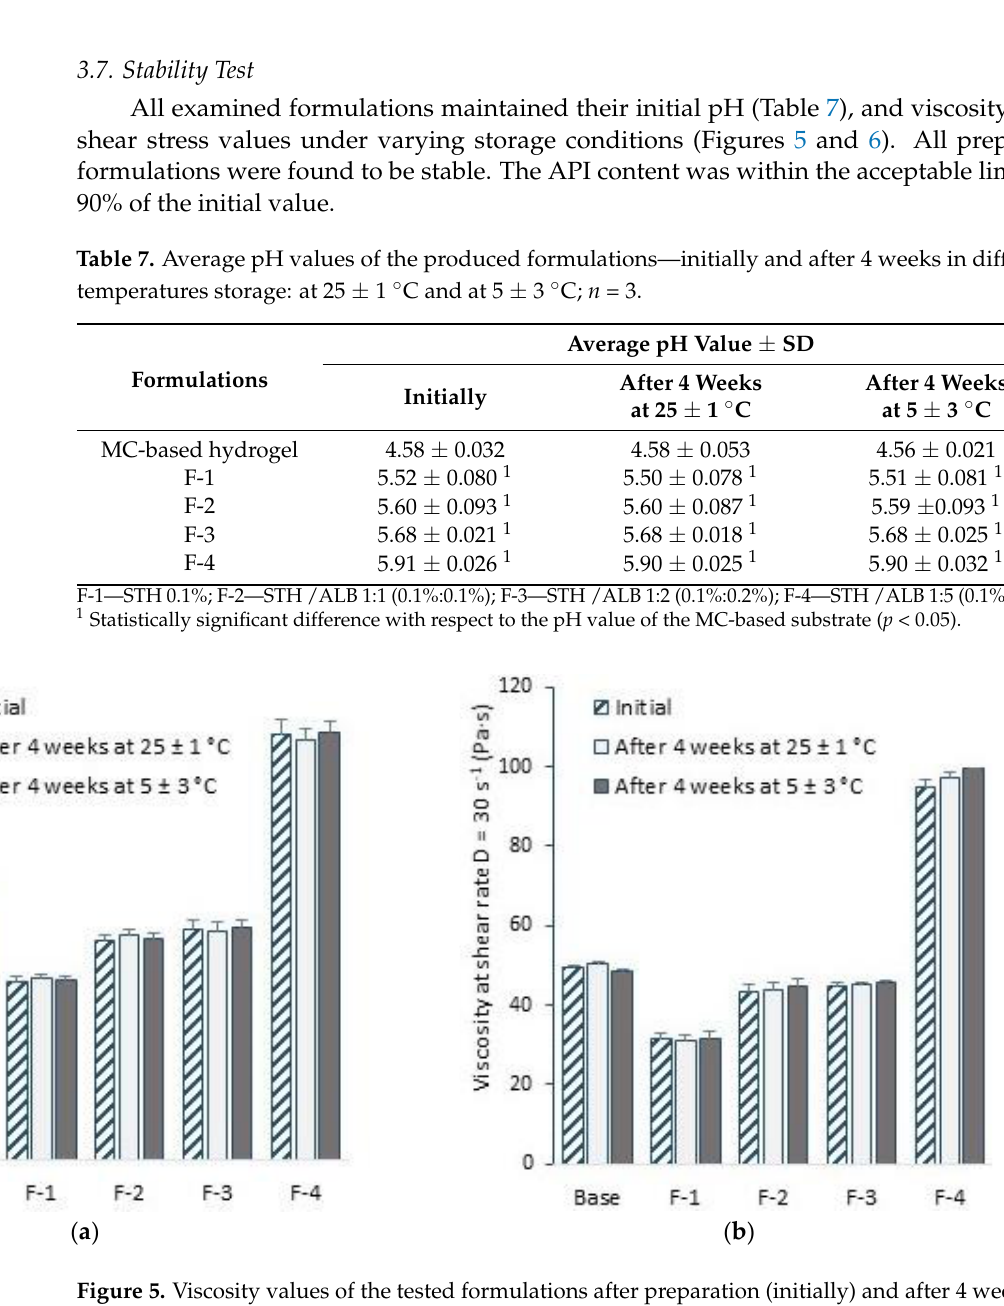
Figure 5. Viscosity values of the tested formulations after preparation (initially) and after 4 weeks of storage at different temperatures, measured at two different shear rates: ( a ) D = 15 s −1 ; ( b ) D = 30 s −1 .